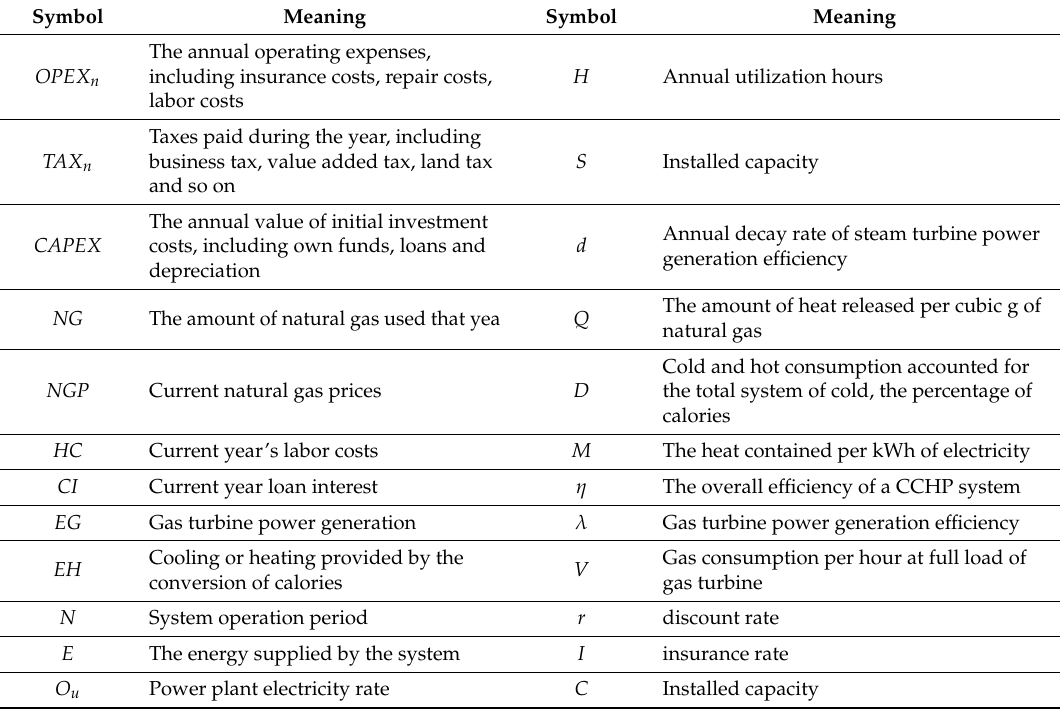
Table 4. Parameters and symbols in the formulas and their